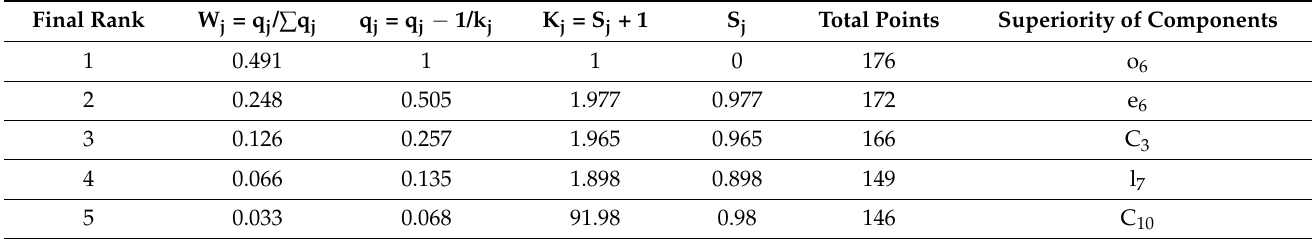
Table 6. Final results of weighing the research criteria by the Swara